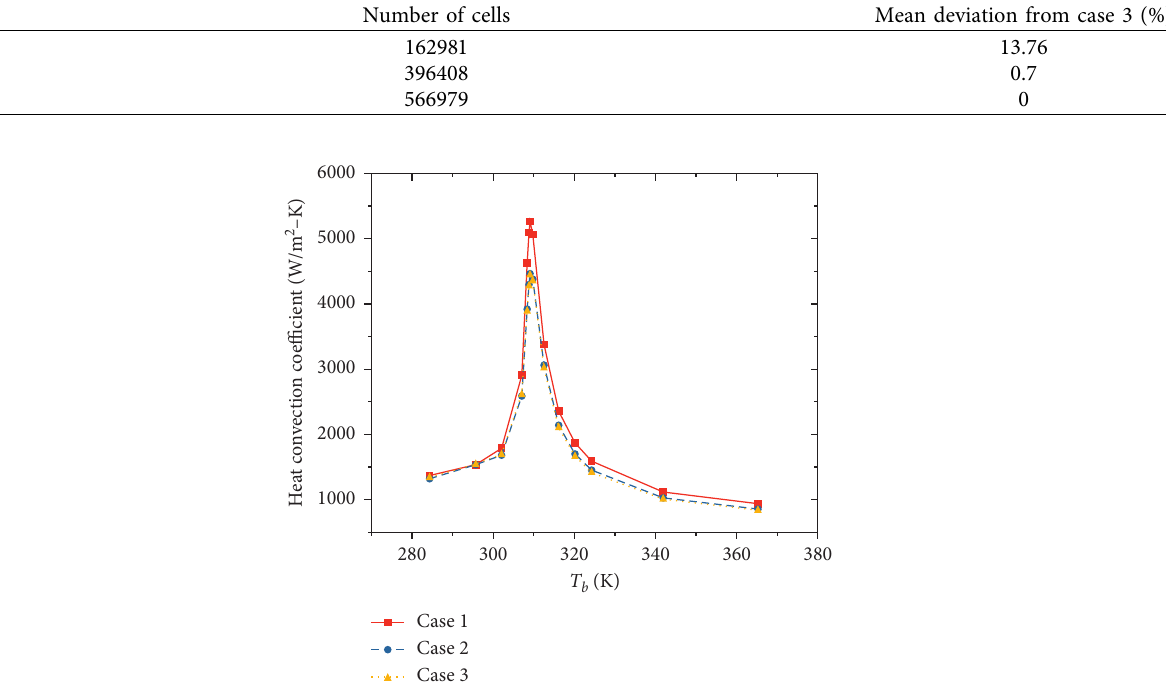
Figure 4: Comparison of the calculated heat convection coefficient of different